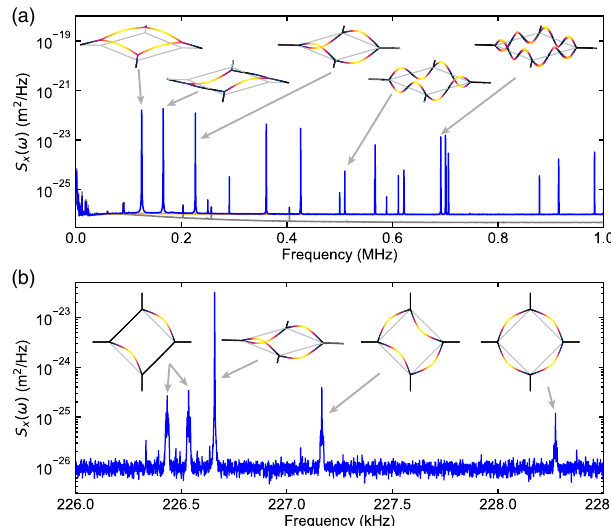
FIG. 12. Mode spectrum of polygon resonators. (a) Blue line: broadband thermomechanical noise spectrum, obtained from the device used in Sec. V. Some of the identified modes are marked with their corresponding mode profile obtained from a FEM simulation. Orange line: signal with only local oscillator light. Gray line: signal with no light incident on detector. (b) Narrow- band displacement spectrum around the perimeter mode of the same device; obtained while applying moderate dissipative feedback. The out-of-plane and in-plane perimeter modes are marked.